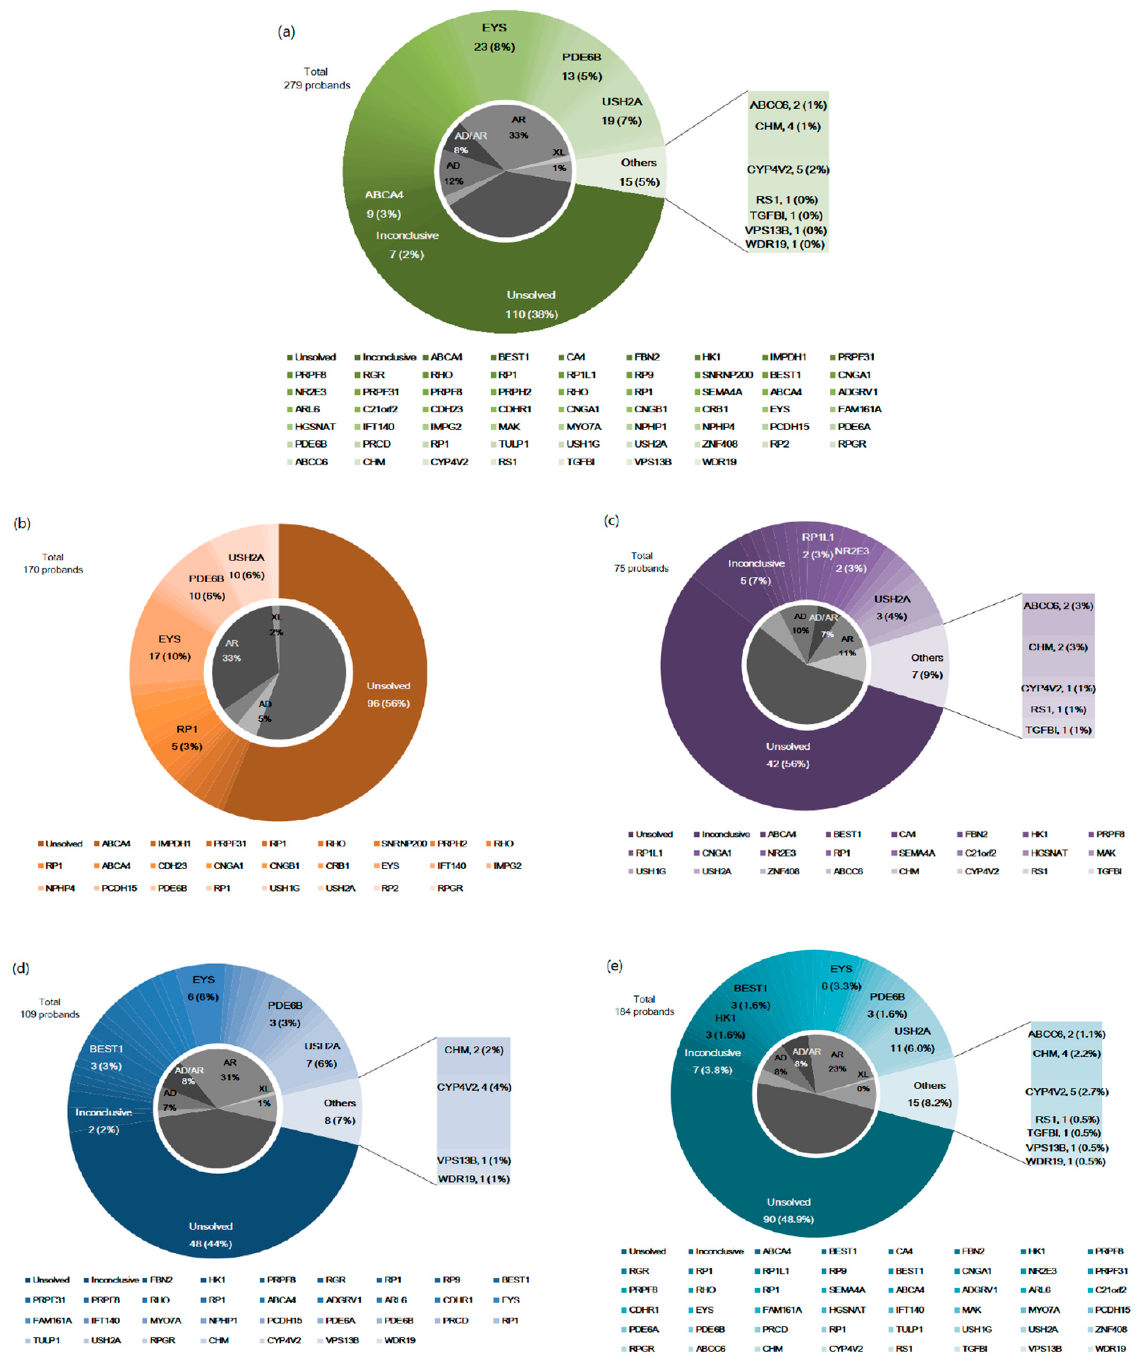
Figure 2. Mutational spectra of 279 probands with retinitis pigmentosa. ( a ) Mutational spectrum of total subjects, combining targeted next-generation sequencing (TGS) and whole exome sequencing (WES). ( b ) Mutational spectrum of patients who underwent TGS. ( c ) Mutational spectrum of patients who underwent WES due to TGS with inconclusive results. ( d ) Mutational spectrum of patients who underwent WES only. ( e ) Mutational spectrum of total patients who underwent WES with inconclusive TGS results and WES only. AD, autosomal dominant; AR, autosomal recessive; XL, x-linked inheritance.